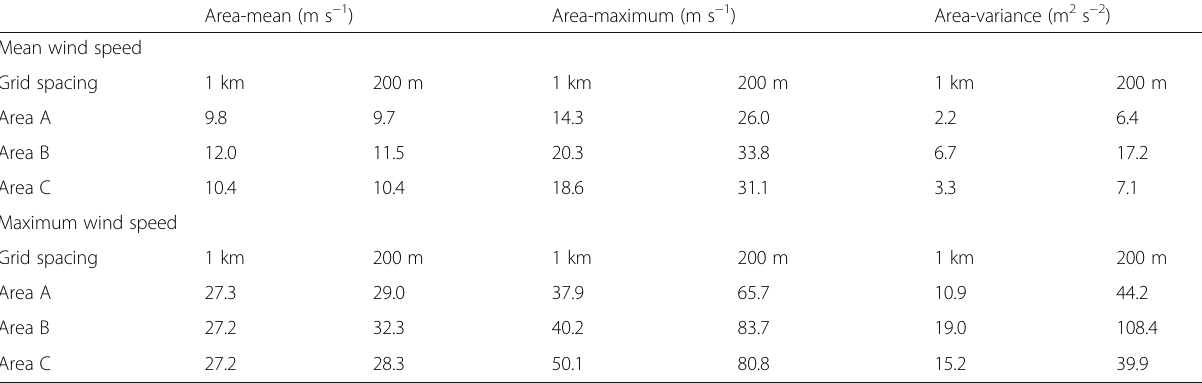
Table 1 Statistics of the mean and maximum wind speeds in the analysis areas. The results of mean and maximum wind speeds during the simulated time period obtained in the 1 km grid and 200 m grid cases for the areas A, B, and C are summarized. The statistics are the area-mean, area-maximum, and spatial variance values computed from the temporal mean and maximum winds in each analysis area